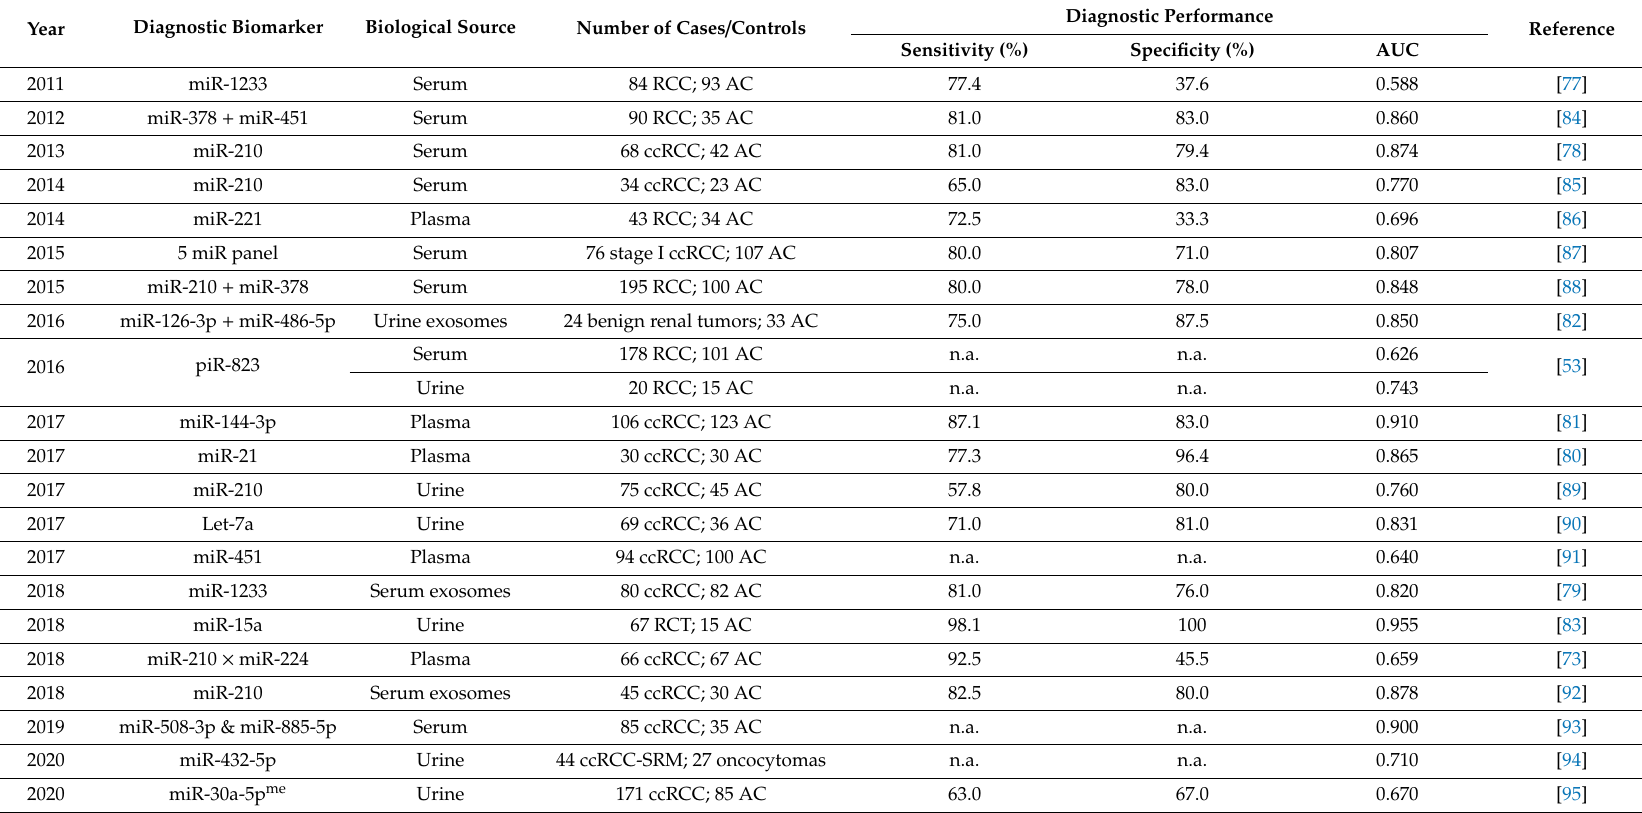
Table 2. Overview of di ff erent proposed diagnostic biomarkers for RCT in liquid